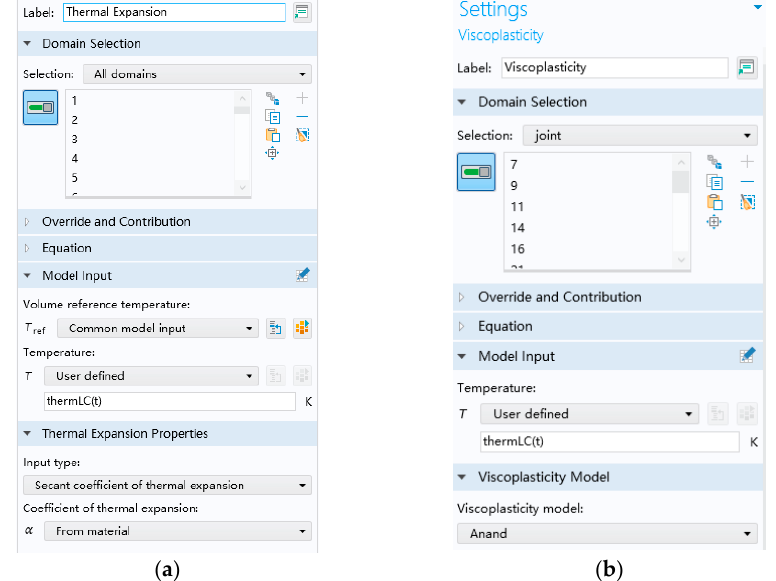
Figure 5. The settings of ( a ) thermal expansion module; ( b ) viscoplasticity module.